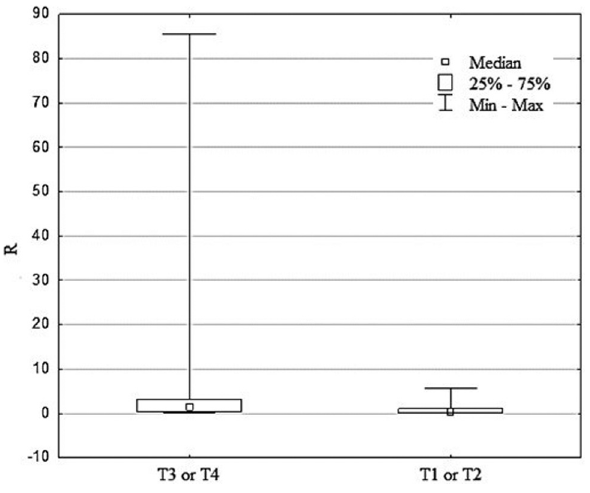
Figure 2 - Comparison of ACVR2A expression level (R) with size and depth of primary tumor invasion (T) according to TNM